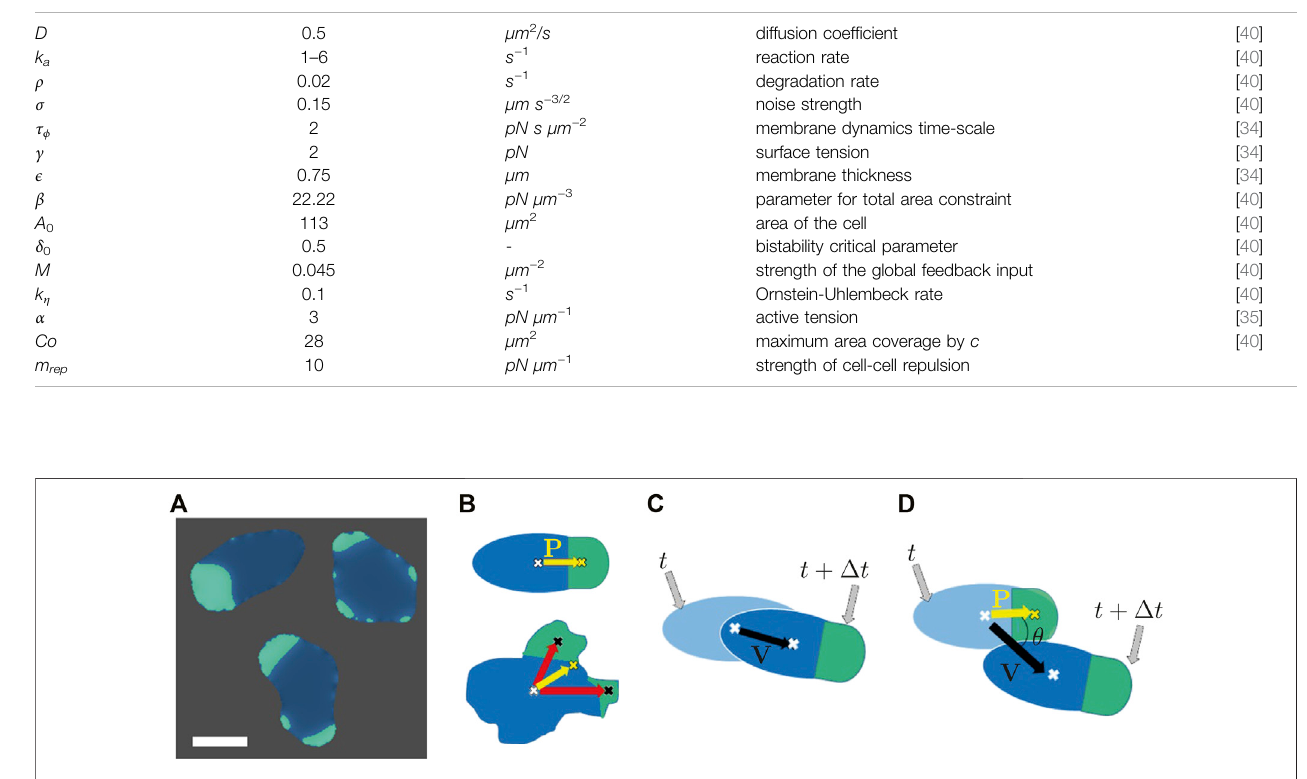
TABLE 1 | Parameter values for the numerical model. The parameter m rep , parametrizing the repulsive interactions, is introduced in this work and, therefore, no reference is given. Parameter